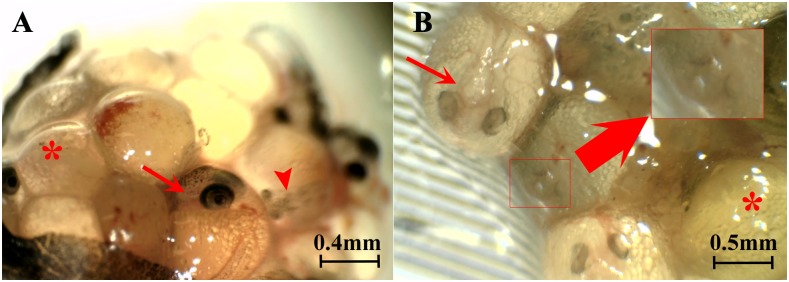
Dissected ovarian sac of two G. holbrooki females showing embryos at multiple stages of development suggesting superfetation.(A). A developed (stage IV; arrow) as well as an early stage (stage II; arrow head) embryo alongside mature unfertilized eggs (asterisk). (B) Stage II (arrow) and stage I embryos (inset) together with mature unfertilized eggs (asterisk).